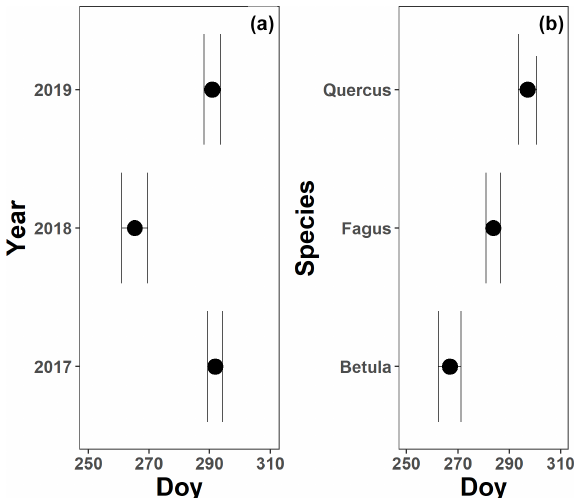
Figure A5. The mean onset of the loss of canopy greenness for 3 years ( a ; 2017–2019) and the three species ( b ; Fagus sylvatica , Betula pendula and Quercus robur ) measured on all mature trees at the Klein Schietveld and Park of Brasschaat. Black dots represent the mean onset of the loss of canopy greenness, while the error bars represent standard errors that indicate the inter-individual variability. All breakpoints are calculated using the loss of canopy greenness data and piecewise linear regressions ( n Fagus = 16; n Betula = 8; n Quercus =